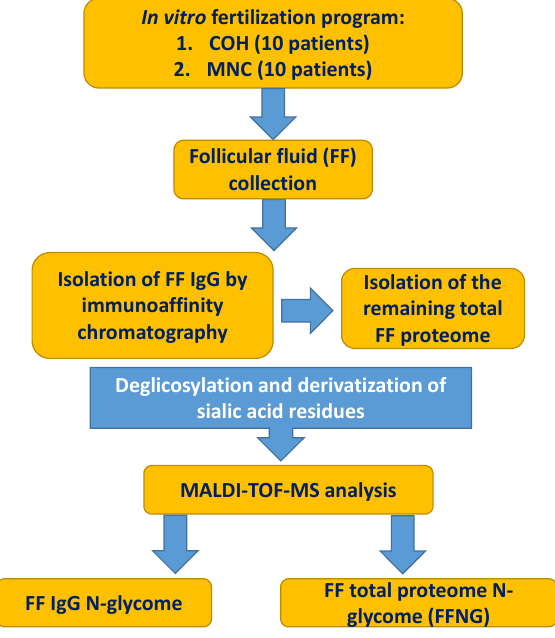
Figure 1: Experimental workflow applied for isolation and analysis of follicular fluid (FF) IgG N-glycome and FF total proteome N-glycome from 10 patients in the modified natural cycle (MNC group) and 10 patients subjected to the controlled ovarian hyperstimulation procedure (COH group). MALDI-TOF-MS, matrix assisted laser desorption ionization time-of-flight mass